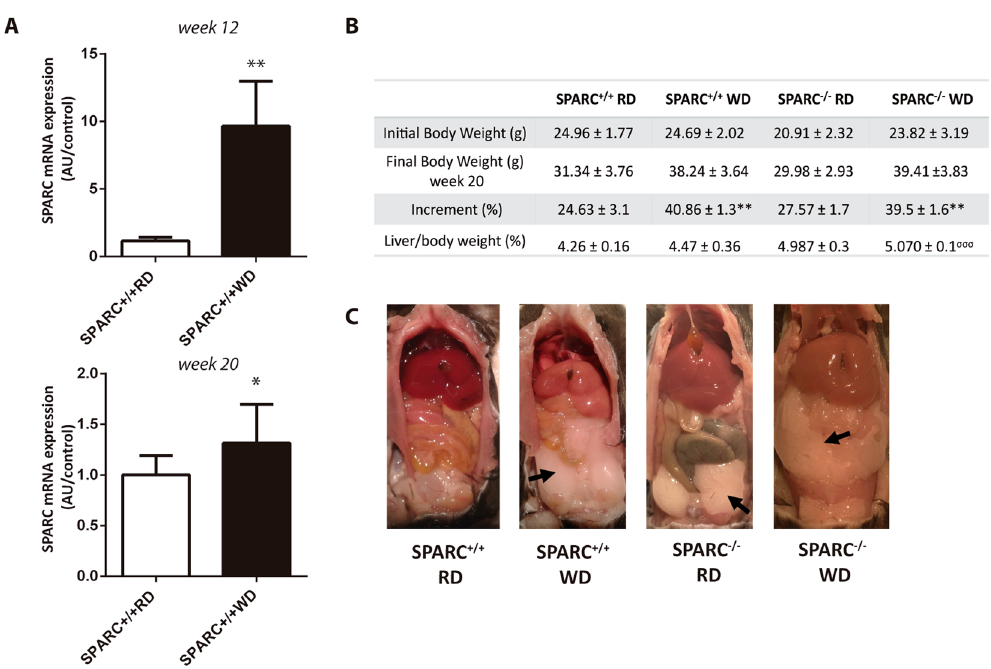
Figure 4. SPARC expression in murine dietary NASH model. ( A ) Hepatic SPARC expression detected by qPCR in the high fat diet (HF) model of NASH in mice. After 12 (upper panel) and 20 (lower panel) weeks of western diet (WD), SPARC expression was significantly induced compared with mice fed with regular chow (RD). ( B ) Body and liver weight increment after 20 weeks. Data are means ± SEM. * , compared between WD and RD diet; σ , compared between SPARC − / − and SPARC + / + fed with WD diet. * p < 0.05, ** p < 0.01, σσσ p < 0.001; Kruskal- Wallis test. ( C ) Visceral adipose tissue deposition (black arrow) and appearance of the liver in SPARC − / − and SPARC + / + fed with WD or RD diet for 20